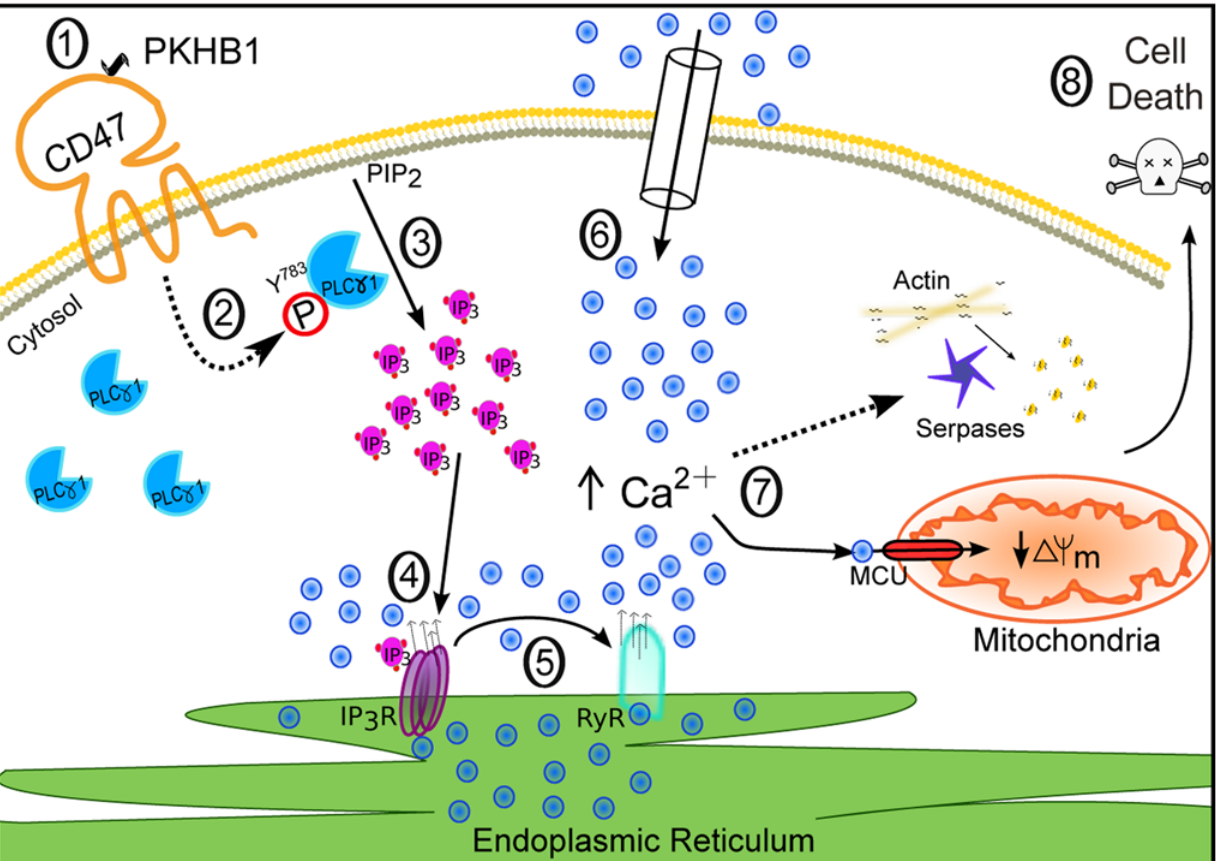
Fig 8. Schematic representation of CD47-mediated PCD in CLL cells. CD47 ligation by the agonist peptide PKHB1 (1) leads to activation of the over- expressed second messenger PLC γ 1 by phosphorylation at Y783 (2). PLC γ 1-Y783 cleaves phosphatidylinositol 4,5 bisphosphate (PIP 2 ) into inositol 1,4,5- trisphosphate (IP 3 ) (3), which binds IP 3 Rs in the ER to provoke Ca 2+ release (4). The increased intracellular Ca 2+ concentration activates the ER RYRs (5). The decrease of Ca 2+ in the ER results in the opening of store-operated Ca 2+ channels in the plasma membrane, provoking substantial calcium entry into the cell (6). This high Ca 2+ concentration provokes serpase activation, actin depolymerization, and mitochondrial damage (7), followed by PCD